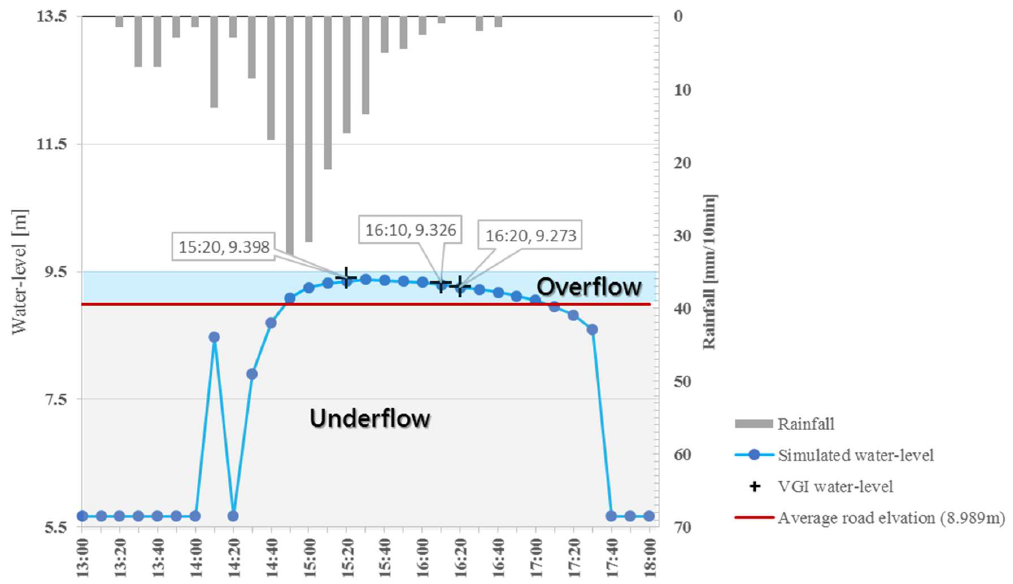
Figure 7. Rainfall hyetograph and corresponding water level distribution.